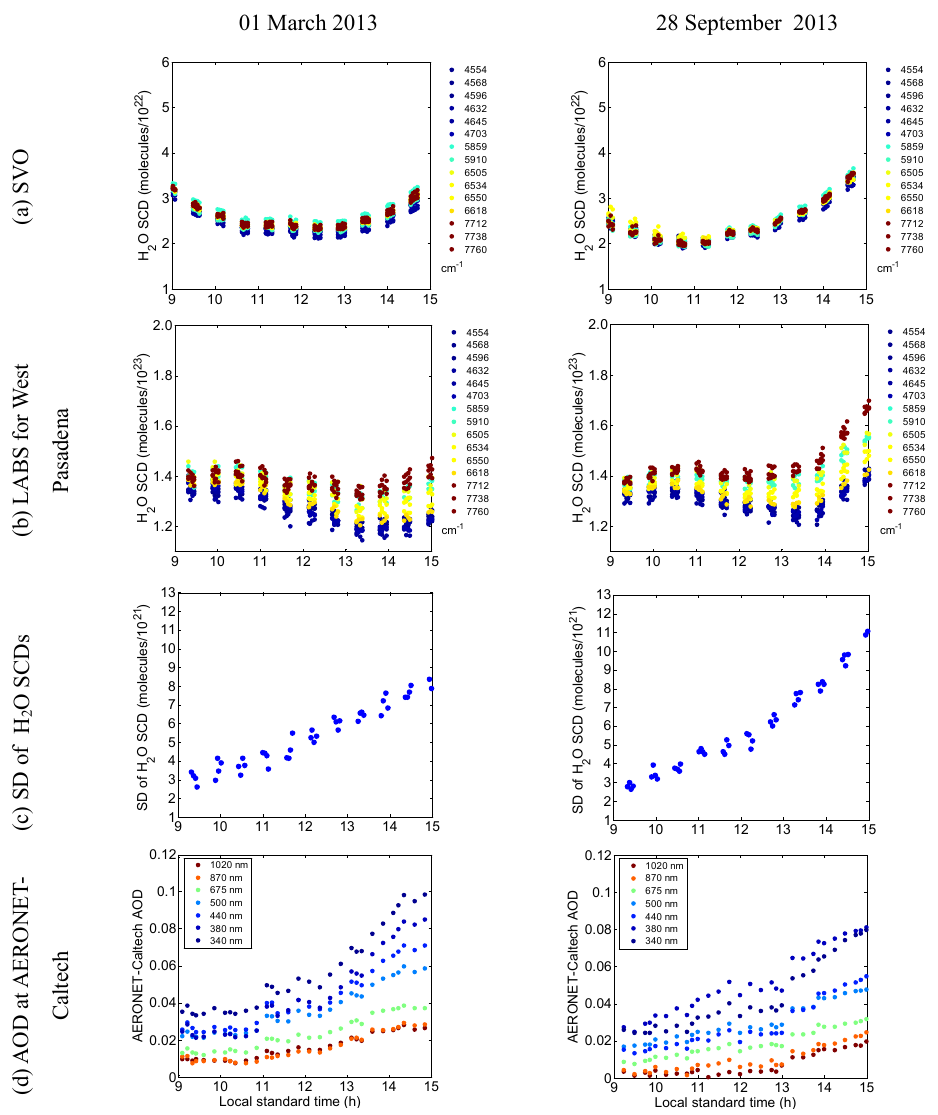
Figure 3. Daily Variations of CLARS H 2 O SCD retrievals for the western Pasadena target and AOD measurements from AERONET-Caltech station on 1 March 2013 (left column panels) and 28 September 2013 (right column panels). H 2 O SCD retrievals from SVO mode are shown in (a) , and from LABS mode for western Pasadena are shown in (b) . The corresponding standard deviations of H 2 O SCD retrievals, a measure of the degree of variation in the retrievals, are shown in (c) and the AOD measurements from AERONET-Caltech are shown in (d)